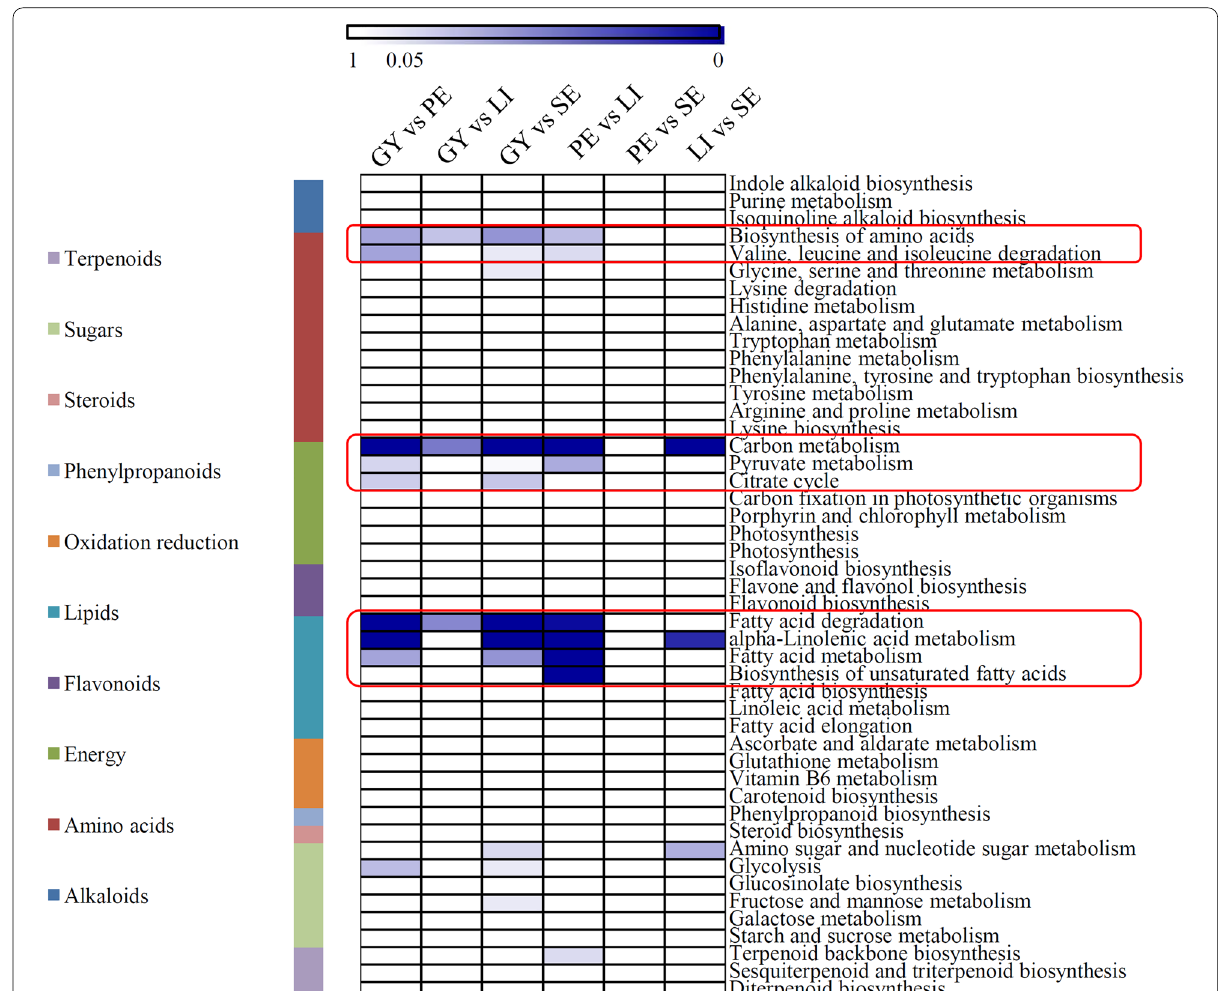
Fig. 3 KEGG enrichment analysis of all the DEPs in different comparisons. The significant P values of each KEGG term in the six comparisons were shown by heatmap. The heatmap scale ranges from 0 to 1. The red boxes indicated the significant differentially KEGG